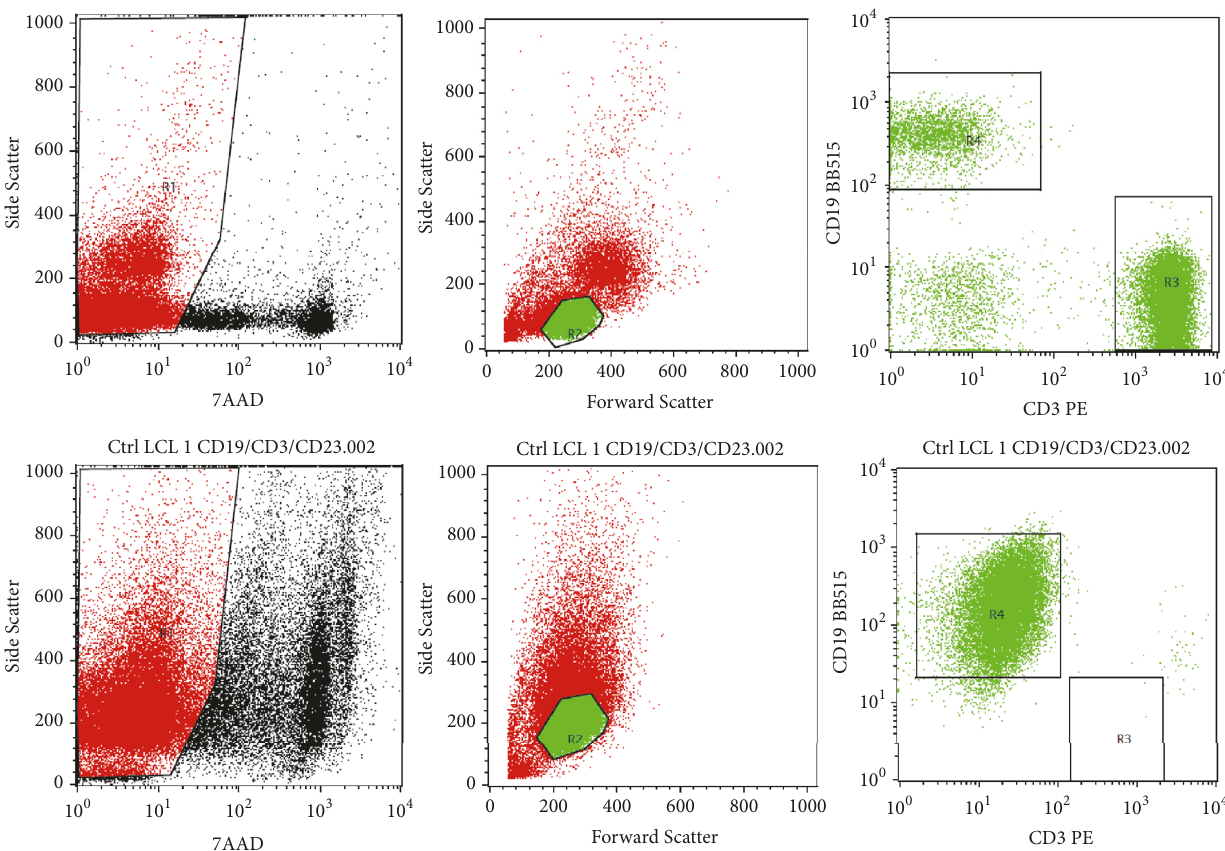
Figure 3: T-cell (CD3) and B-cell (CD19) surface marker profiling by flow cytometry. The upper panel shows the analysis of PBMCs isolated from patient 8A while the lower panel shows the analysis of the corresponding LCLs (LCL-8A). R1 : 7AAD − live cells; R2 : gated lymphocytes; R3 : gated CD3 + T-cells; R4 : gated CD19 + B-cells.